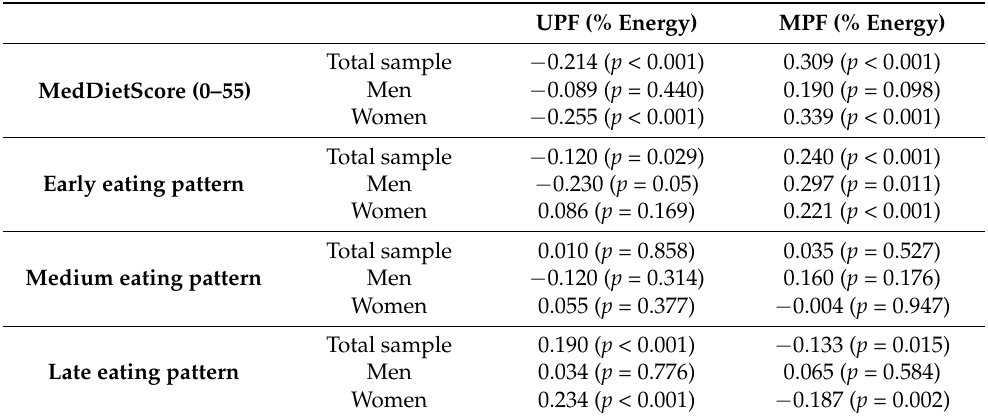
Table 7. Spearman correlation coefficients between UPF, MPF consumption, MedDietScore and early, medium and late eating meal